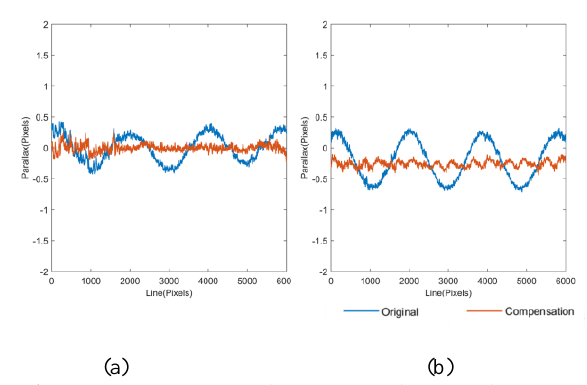
Figure 9 . CCD3 parallax of B1and B2 before and after jitter compensation ((a) is the along-track direction parallax (b) is the cross-track direction